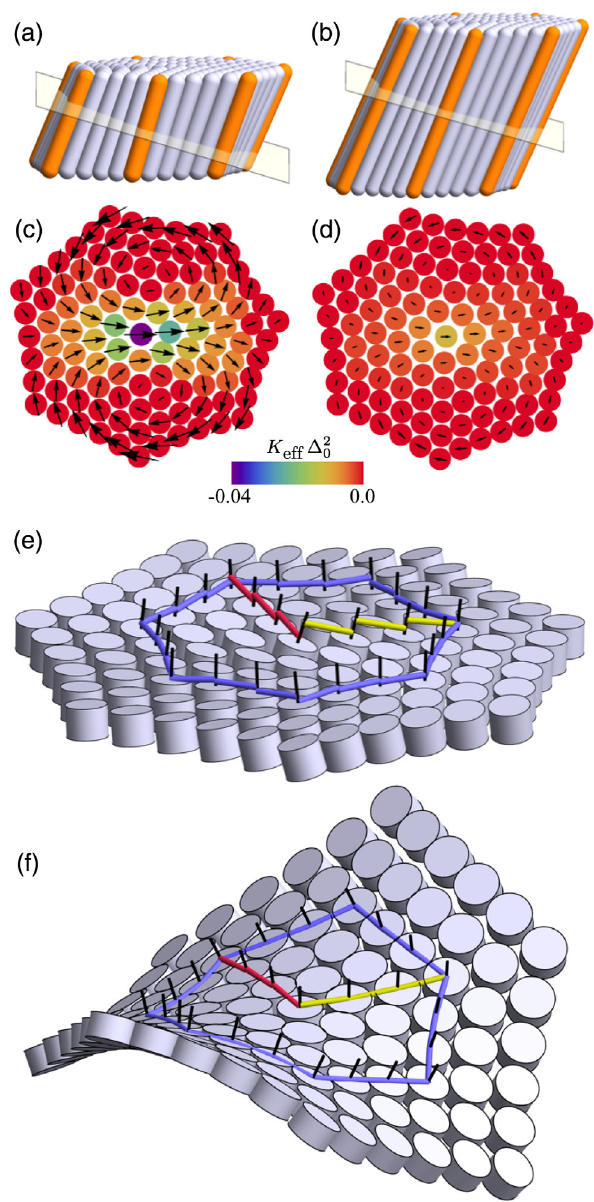
FIG. 7. Visualizations of infinitely rigid ( γ ¼ 0 ) filaments with R= Δ 0 ¼ 5 and (a) L=R ¼ 1 and (b) L=R ¼ 2 . Panels (c) and (d) show cross-sectional cuts through the bundles, with filaments colored by their local equivalent Gaussian curvature from Eq. (C1). The arrows point in the direction of tilt of each filament away from the average filament orientation. (e) Cross-sectional slice of L=R ¼ 0 . 4 bundle, showing a negative Gaussian curvaturelike tilt pattern. The colored lines represent the distance of closest contact between neighboring filaments. The blue circumferential and red radial paths are relatively unaffected by tilt, while the yellow radial path is shortened due to filaments tilting. (f) Filaments mapped to an equivalent surface with identical colored paths, but with distances now shortened by curvature rather than filament tilt.